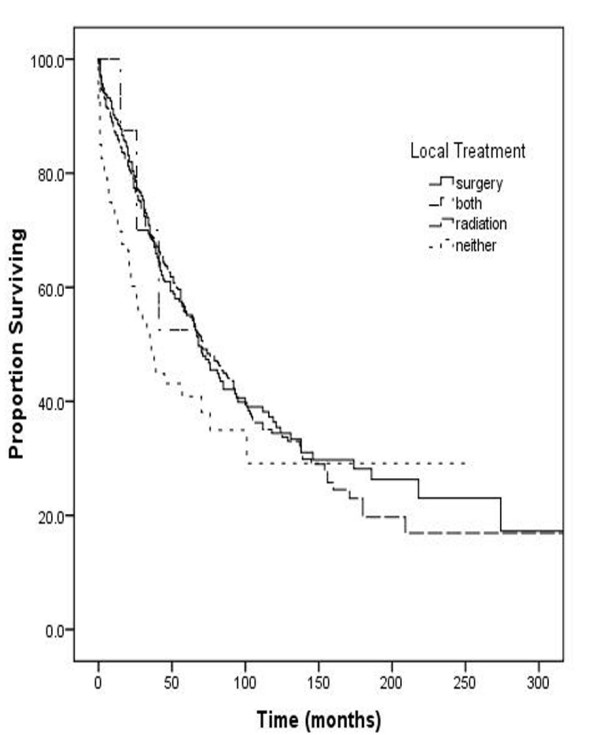
Overall Survival stratified by Local Treatment.